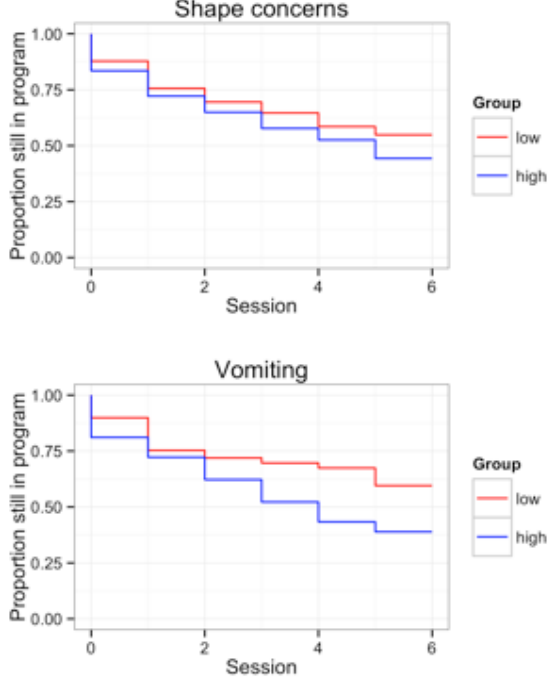
Figure 2. Dropout stratified by high vs low levels of the relevant variables based on median split.